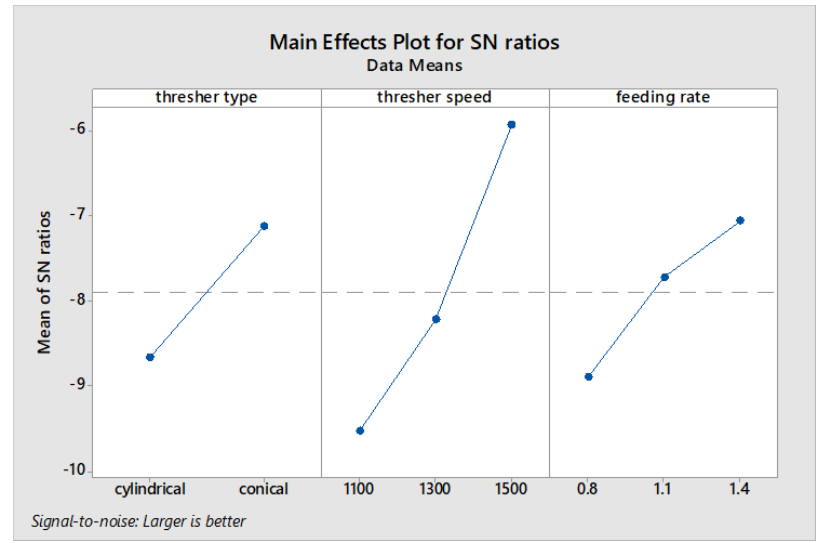
Figure 6. Effect of operating parameters on S/N ratio for productivity. Table 7. Response table for signal to noise ratios for power (smaller is better).